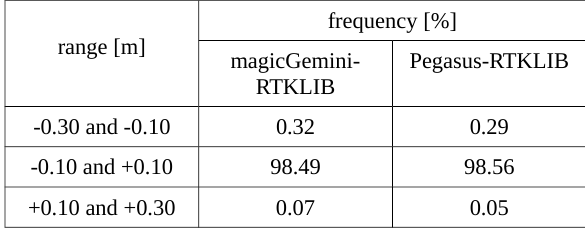
Table 5. Difference in ionospheric delay correction variances